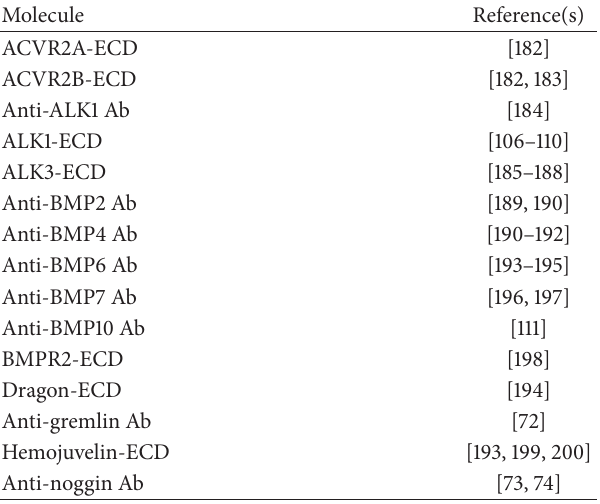
Table 3: Examples of BMP pathway modulation by receptor ECDs or neutralizing